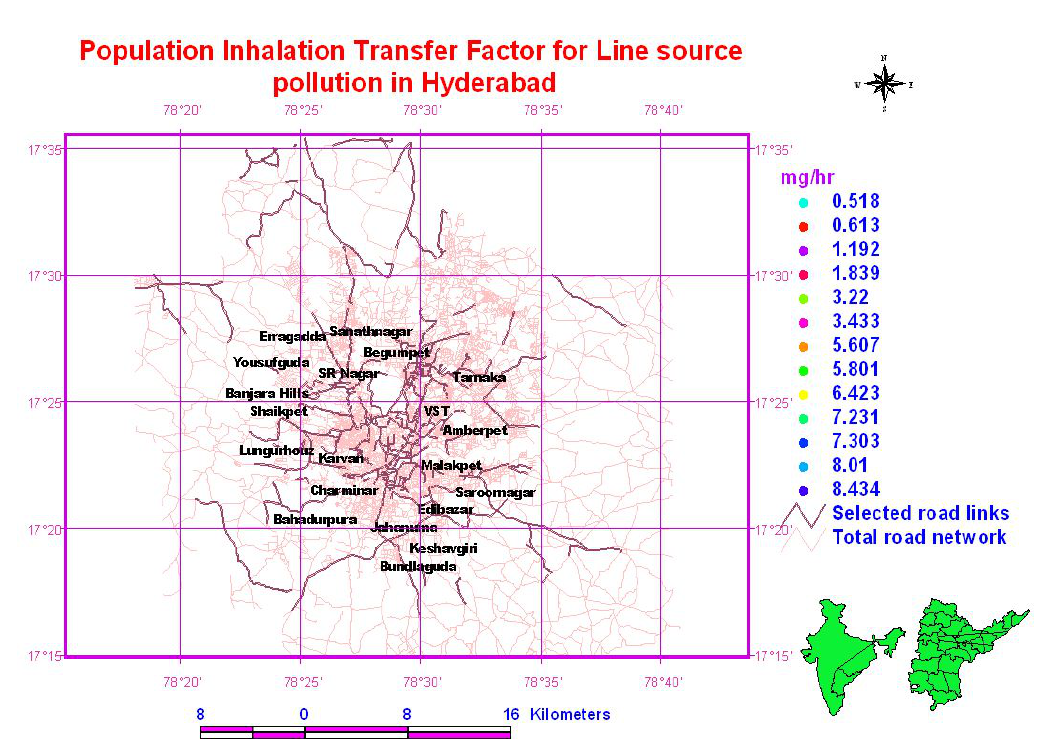
Figure 11: Population inhalation transfer factor for line source pollution in Hyderabad – year